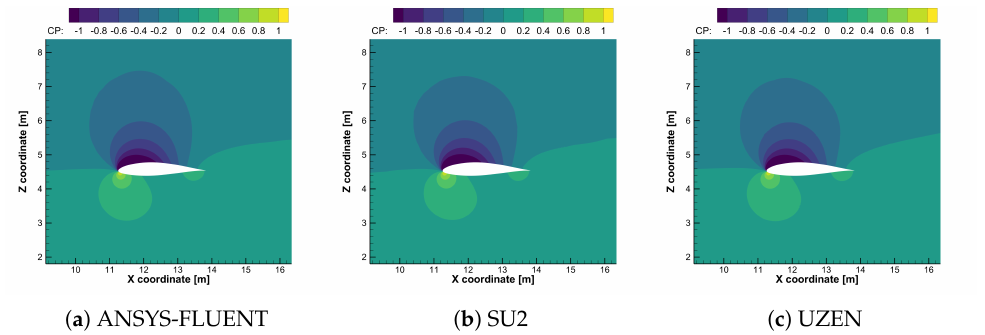
Figure 20. Pressure coefficient contour for power-off condition at α = 8 ◦ .